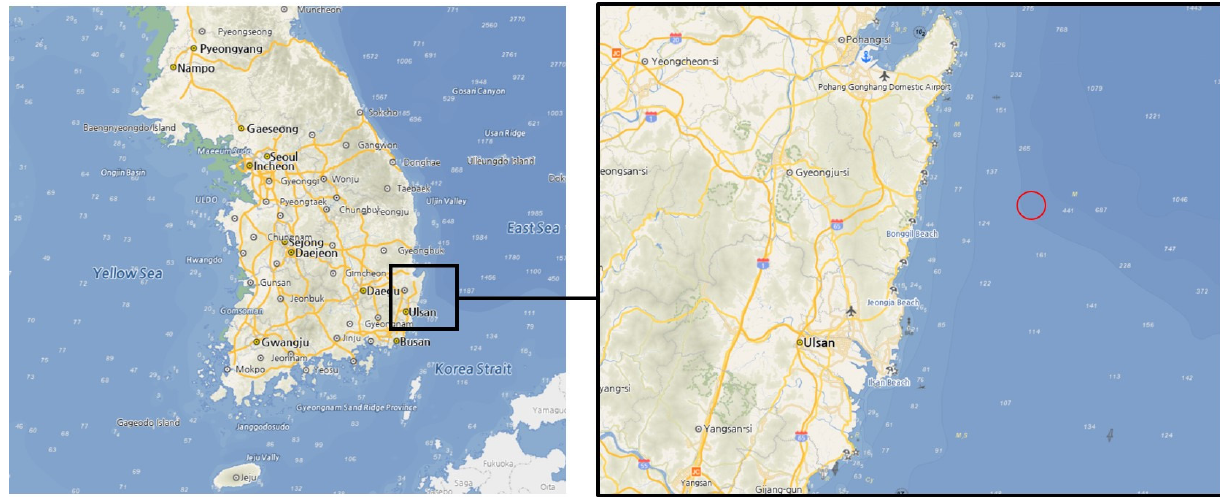
Figure 7. Ulsan sea area used for simulated platform stability analysis. Table 2. Met ‐ Ocean Information.